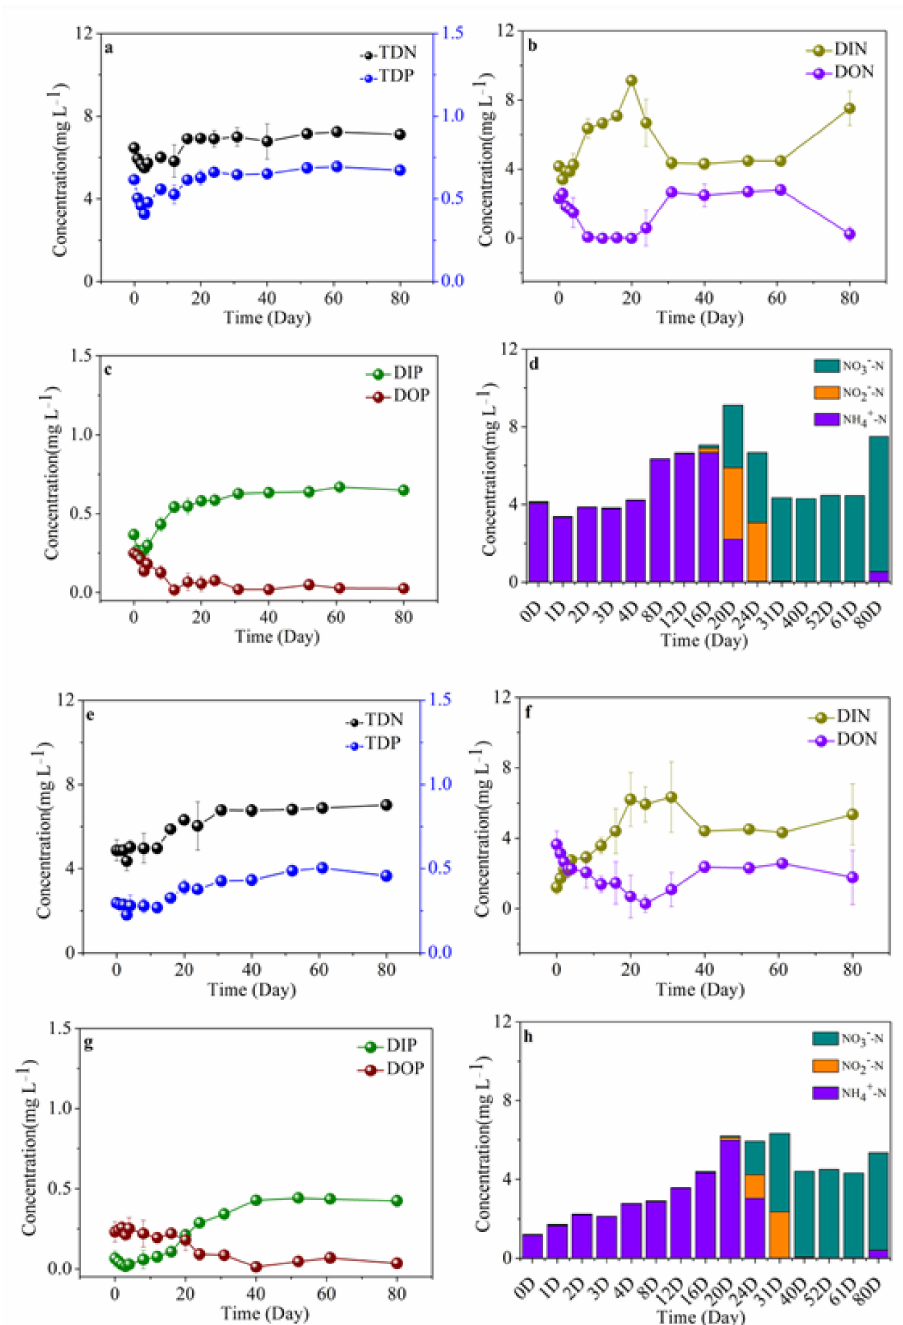
Figure 9. Variations in dissolved nitrogen and phosphorus concentrations and compositions during the 80-d degradation processes of the ( a – d ) algal-derived filtrate group and ( e – h ) algal residual exudative organic matter group. TDN—total dissolved nitrogen, TDP—total dissolved